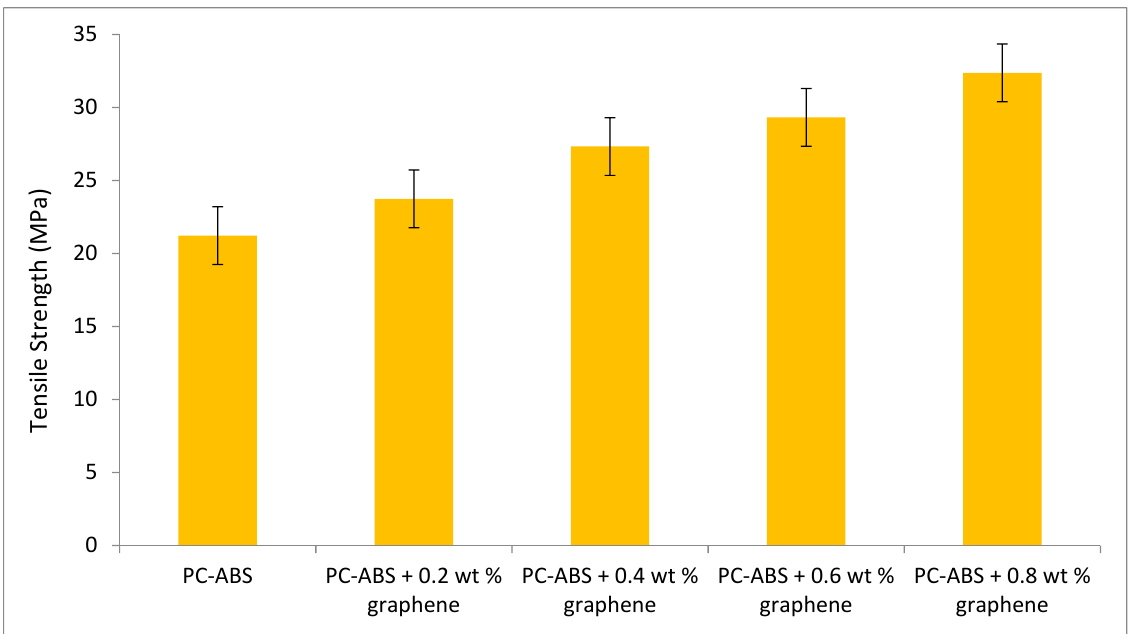
Figure 15. Variation of tensile strength with increase in graphene content. Figure 16 depicts the SEM of the fractured specimens obtained through tensile